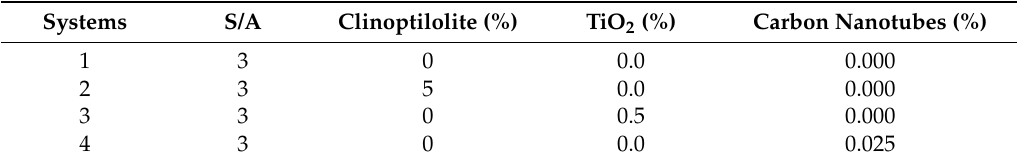
Table 1. Composition of the selected systems, for course of the characterization, with one additive only.